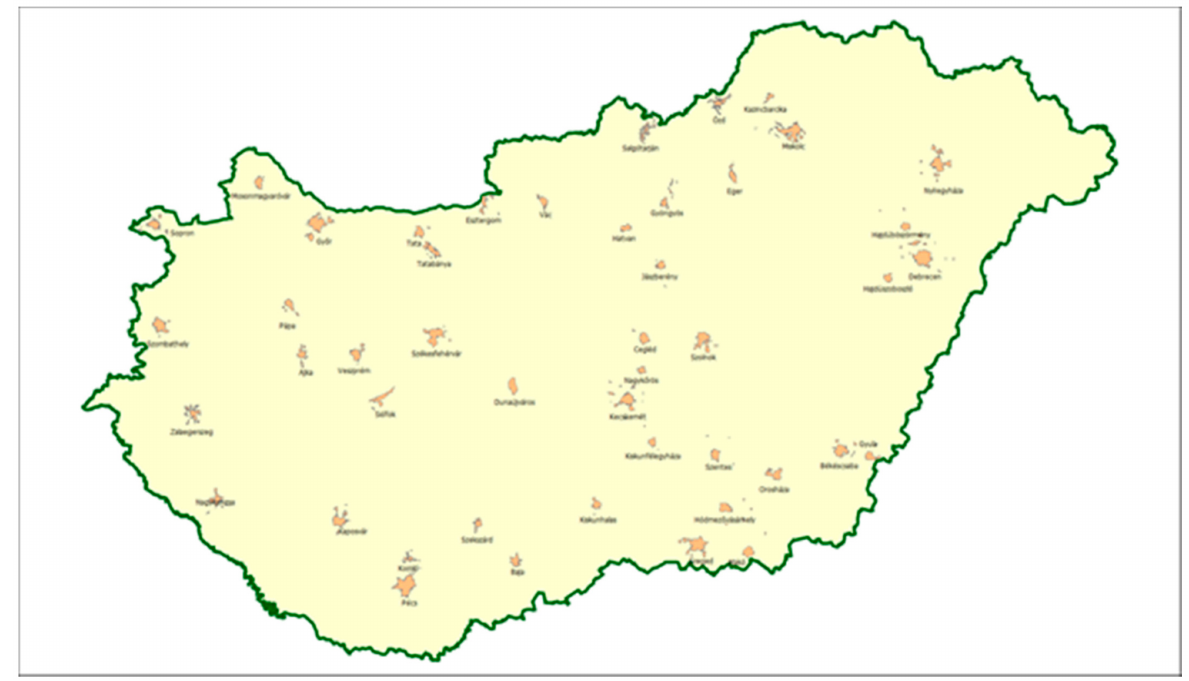
Figure A1. Location of